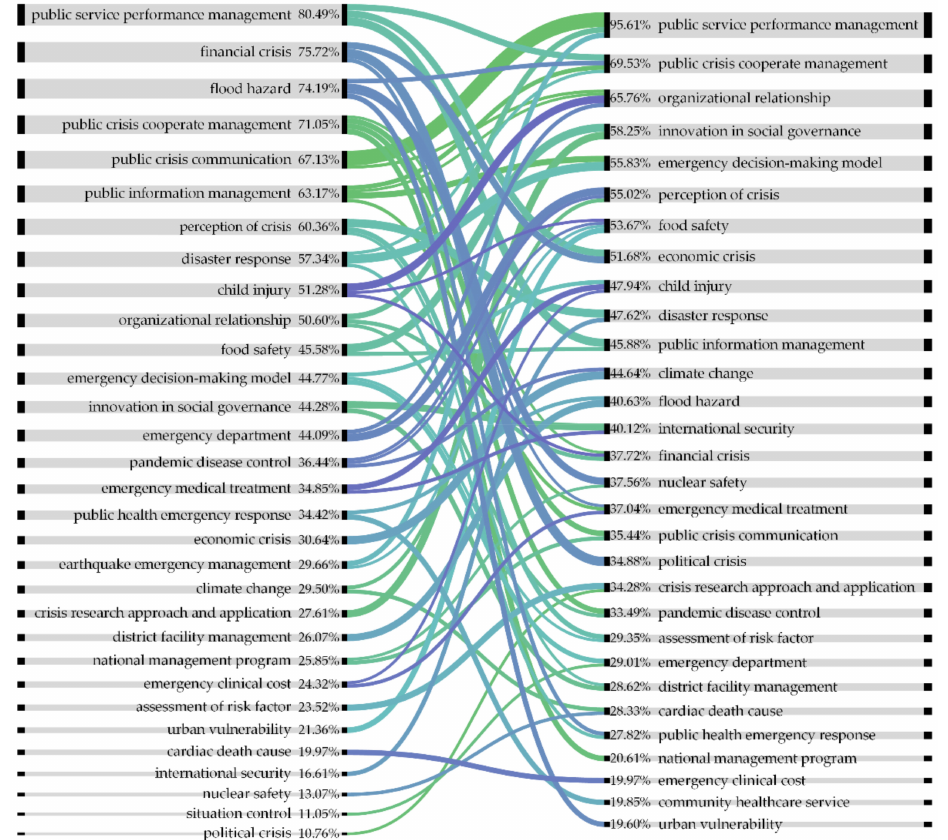
Figure 9. Transition probability estimated by